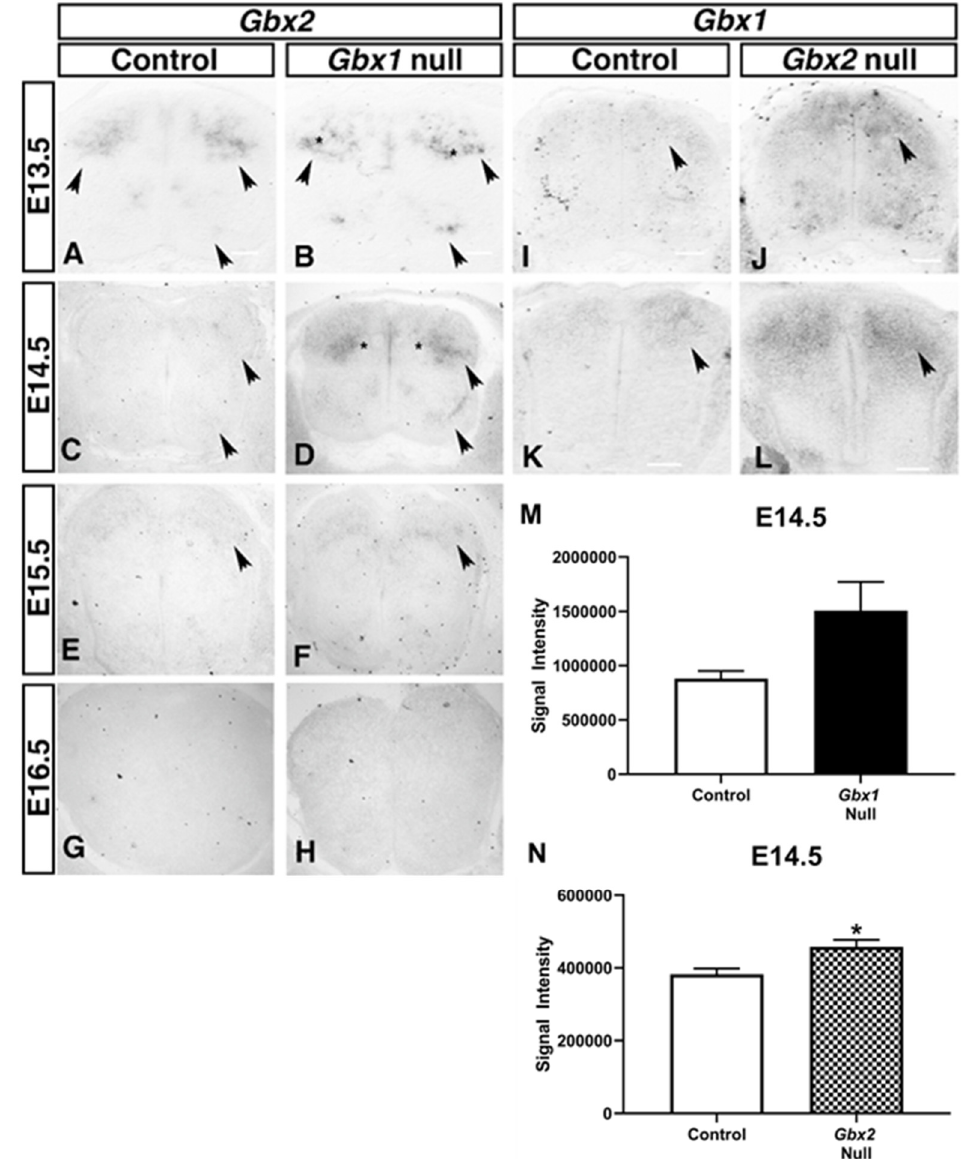
Figure 1. Gbx mRNA expression is transiently upregulated in null counterparts during midembryonic stages. Gbx2 and Gbx1 mRNA expression analysis between embryonic day (E)13.5–E16.5 in Gbx2 − / − , Gbx1 − / − , and age-matched control, lumbar spinal cord sections. In control embryos at E13.5, Gbx2 is expressed within neural populations of the developing dorsal mantle zone ( A ; black arrowhead). Gbx2 expression pattern remains consistent in Gbx1 − / − at E13.5, however, Gbx2 is expressed to a greater extent throughout laminae (III–IV) ( B ; asterisk). Persistent upregulation of Gbx2 expression in Gbx1 − / − spinal cord occurs through E14.5, when compared to control embryo (compare D with C ; black asterisk). Gbx2 expression is barely observable in the control embryo at E15.5 ( E ), and this intensity is comparable in the mutant spinal cord ( F ), which marks the stage in which upregulation of Gbx2 terminates. By E16.5, Gbx2 expression is absent from the spinal cord of control and mutant embryos ( G – H , black arrowhead). Gbx1 expression pattern recapitulates that of the control embryo at E13.5 ( I ), however, Gbx1 is expressed more broadly and intensely throughout the dorsal horn in Gbx2 − / − mutants ( J ). A significant increase in Gbx1 expression persists in the spinal cord of Gbx2 − / − mutants through E14.5, when compared to control embryos ( K – N ). Scale bars represent 100 µm. N = 3 for each genotype, at each stage. Data in graphs shown as mean + SEM. Asterisk indicates significant difference (* p < 0.05, Student’s t-test).